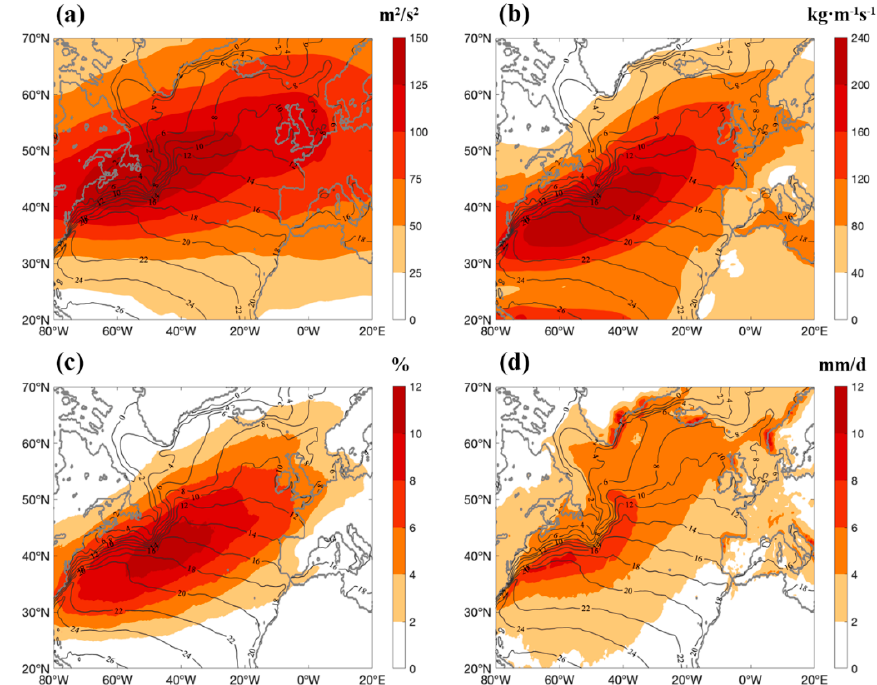
Figure 4. ( a ) Mean eddy kinetic energy (EKE) on 300 hPa during 1997–2019 (m 2 / s 2 ). ( b ) As in ( a ) but for IVT (kg · m − 1 s − 1 ). ( c ) As in ( a ) but for AR occurrence frequency (%). ( d ) As in ( a ) but for total precipitation (mm / d). Contours are the mean SST between 1997 and 2019 ( ◦ C). The frequency is defined as the number of days with an AR divided by the total number of days in winter on each grid.